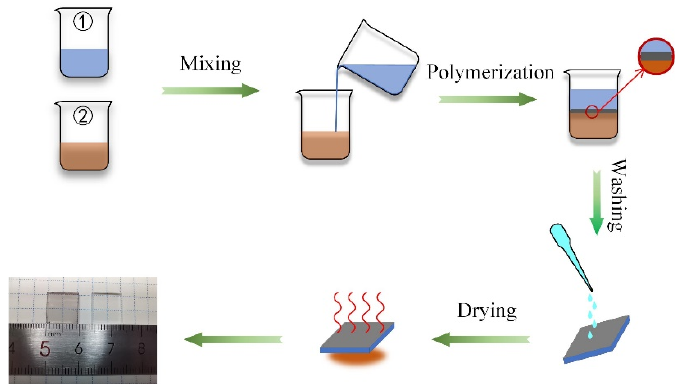
Figure 1. Illustration of the process for preparation of PPy film. ( ① represents an aqueous hydro- chloric acid solution in which ammonium persulfate is dissolved and ② represents a chloroform solution in which pyrrole is dissolved.)